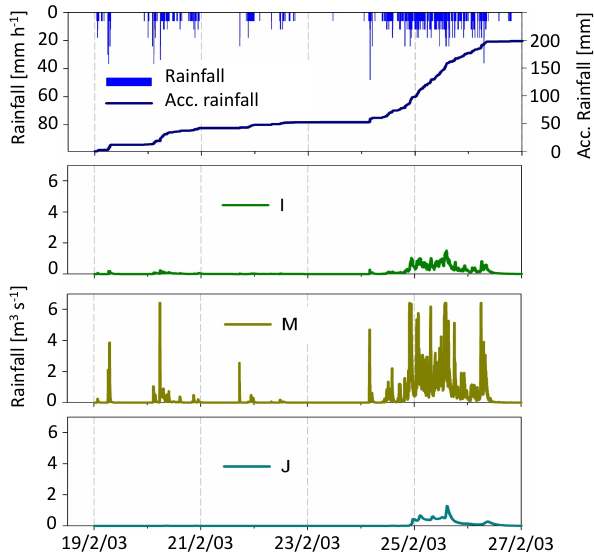
Fig. 8. The extreme event in the Modiin region. Note that station M runoff includes runoff from station I.